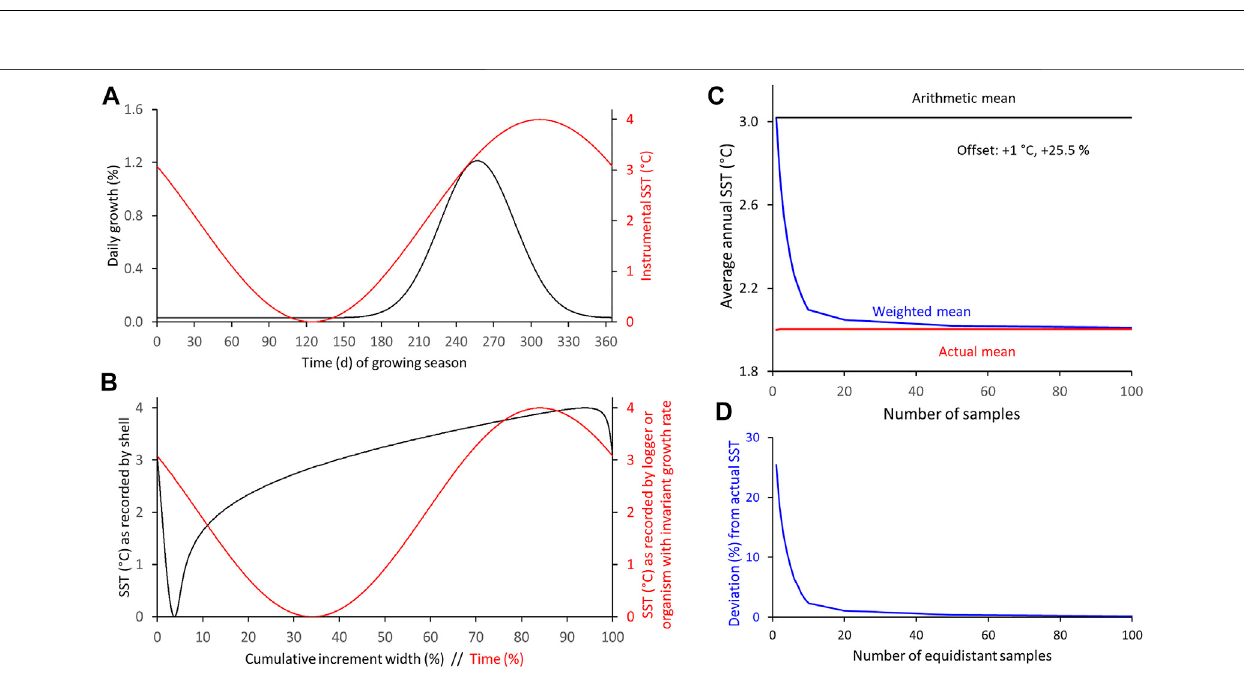
FIGURE 10| Numerical simulation of differences between arithmeticand weighted annual means computed from intra-annual proxy-SSTassuming main growing season (fast growth) is limited to about 5 months, maximum shell growth occurs half-way between SST extremes and both curves are symmetrically shaped. (A) Modeled seasonal shell growth and SST. (B) SSTasrecorded by modelshelland logger. (C,D) Arithmetic and weighted annual proxy-SST incomparison toactual SST mean. With increasing sample resolution, the weighted mean agrees better with the instrumental SST average (C) : absolute values; (D) : relative values.